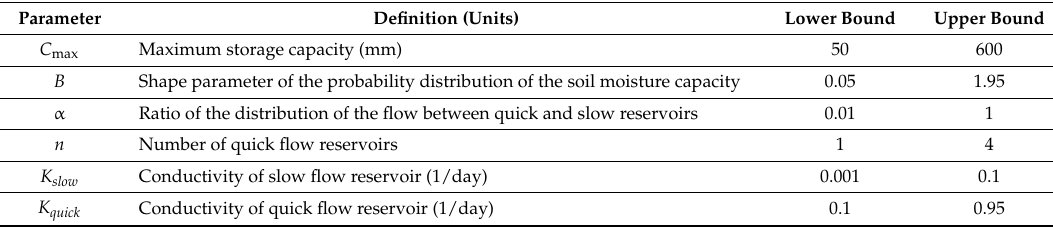
Table 2. Summary of the six parameters in the modified hydrological model (HYMOD) used in this study.